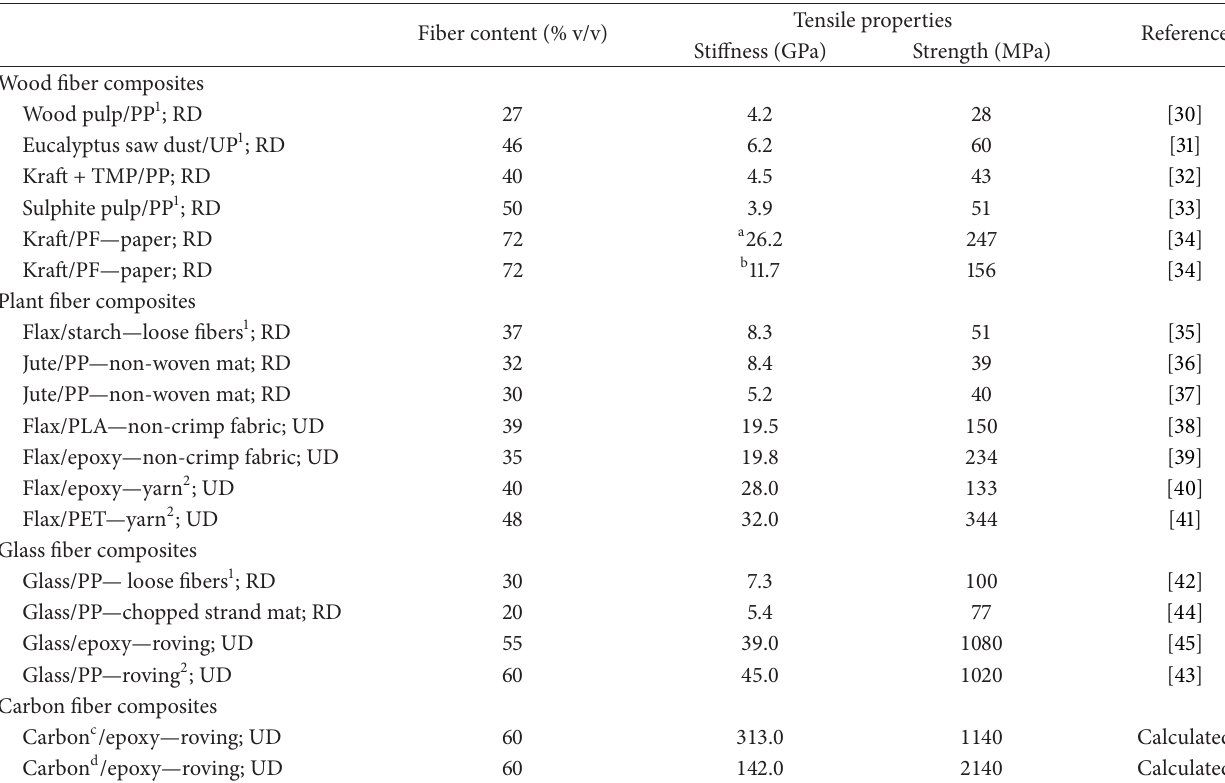
1 Injection molding; 2